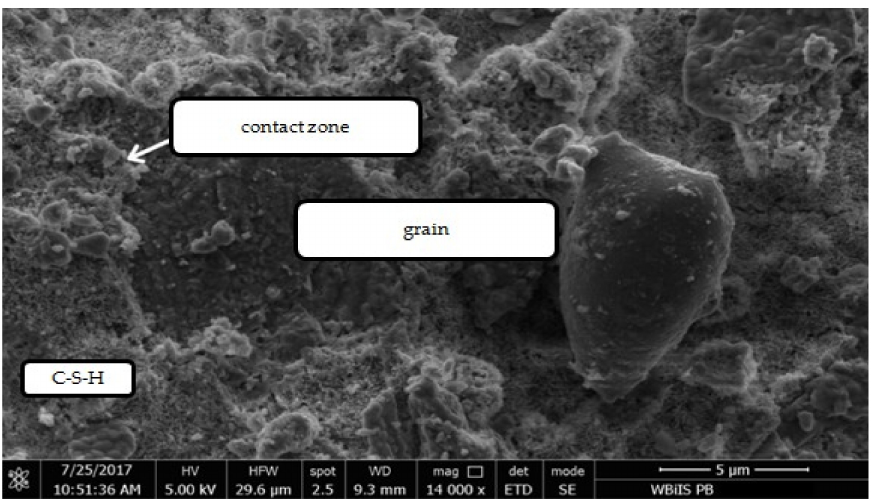
Figure 23. Contact zone between recycled aggregate after thermo-mechanical treatment and cement